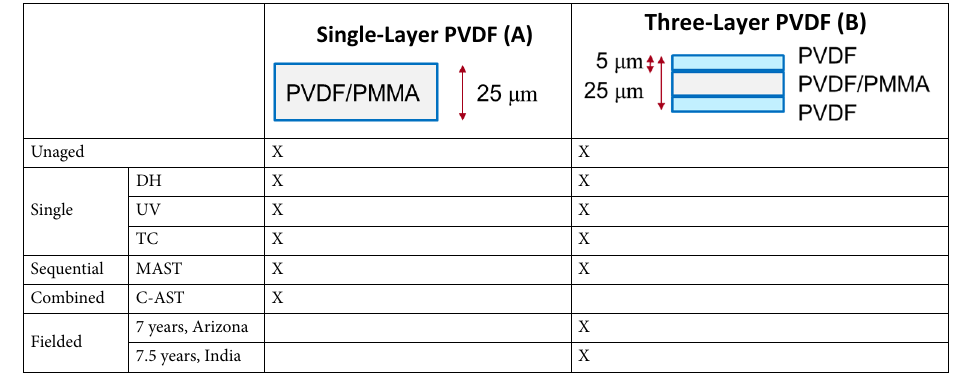
Table 1. Backsheet samples and stress-test